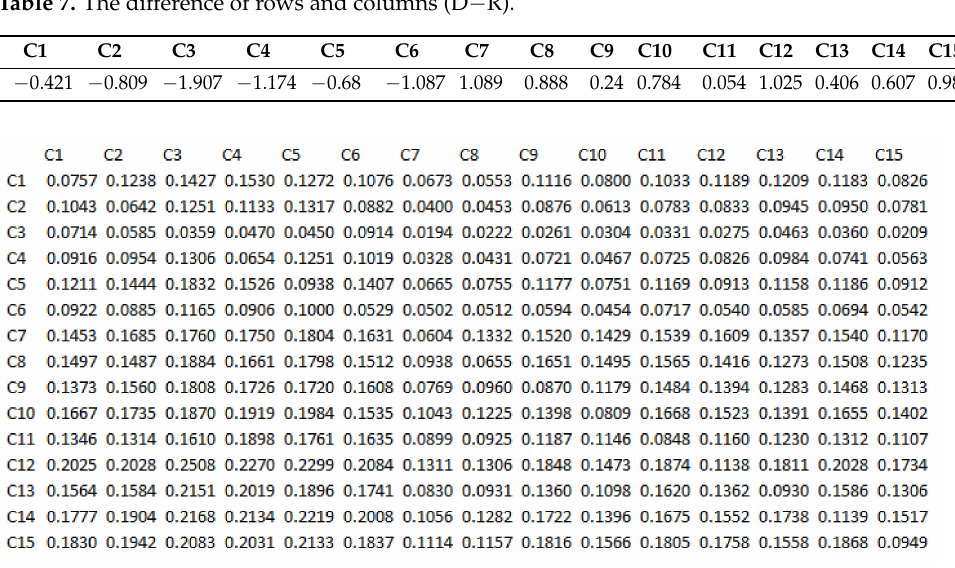
Figure 2. Complete Relationship Matrix